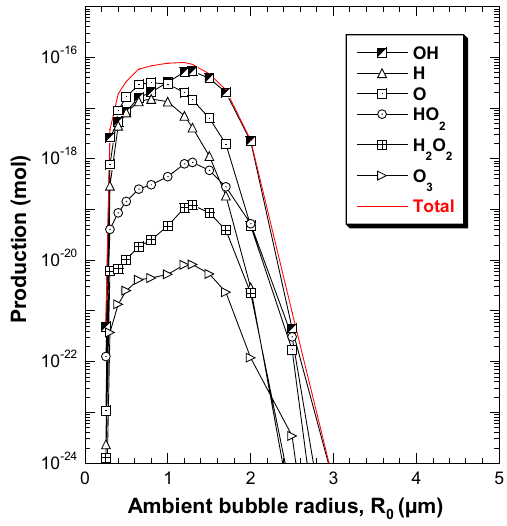
Fig. 5 The number of active bubbles as function of bulk liquid tem- perature (conditions—ambient bubble radius: 1.2 µm, liquid tempera- ture: 25–50 °C, frequency: 1700 kHz, acoustic power: 15